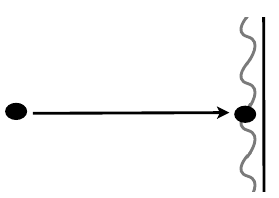
Figure 4 . In holographic theories scrambling is described by the interaction of a particle with near-horizon degrees of freedom. The wavy line in the plot represents a stretched horizon while solid line the event horizon. As a particle falls into a black hole, from the perspective of an outside observer, the particle is \dissolved" into the thermal cloud of a stretched horizon. Such a process may be interpreted in the dual quantum (cid:12)eld theory as building up a hydrodynamic cloud. degrees of freedom constitute a universal sector among all quantum many-body systems, it is then natural to search for a hydrodynamic origin of the chaotic behavior (1.5){(1.8) (see also [35{37] for other attempts to connect chaos and